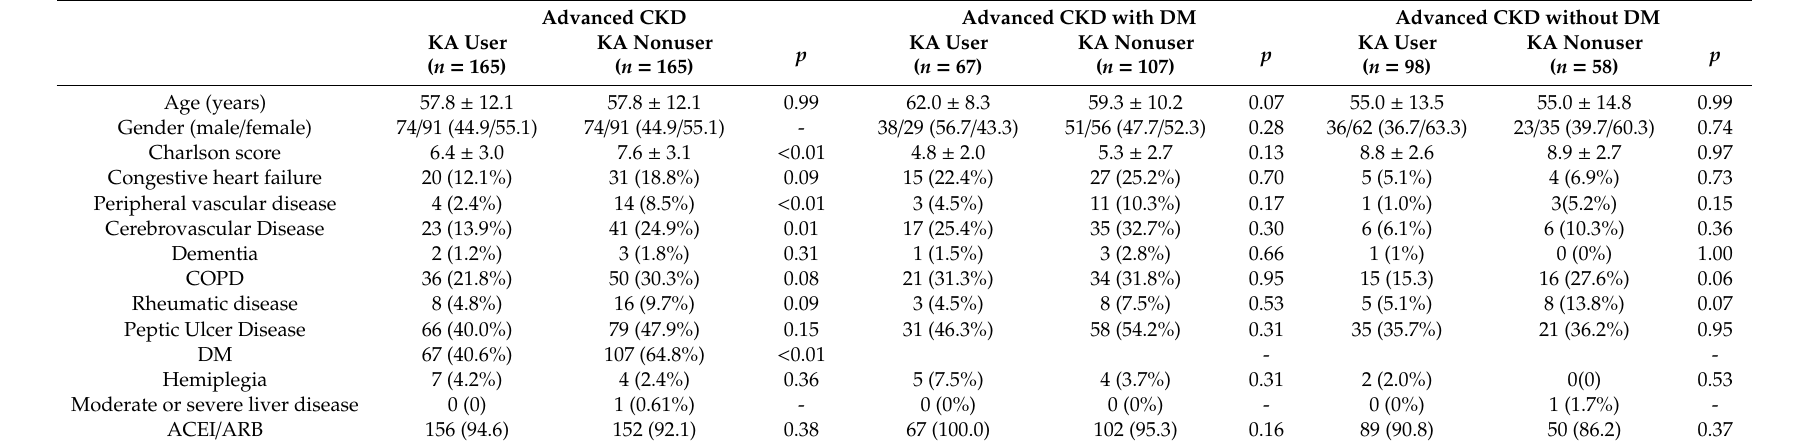
Table 2. Patient